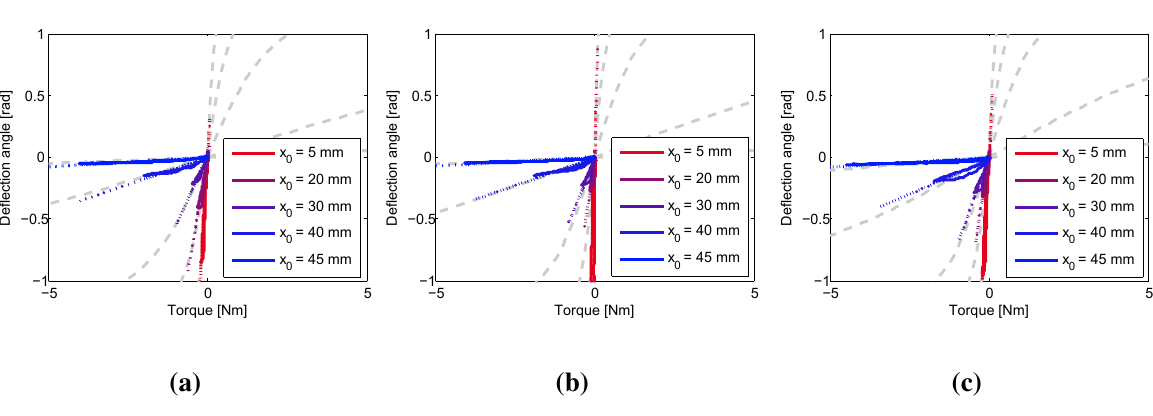
Figure 14. Deflection/torque measurement results using a single-leaf spring (for clarity, only half of the measurements are shown). The dashed line represents the simulated deflection/torque data, and the dotted line is the linear least squares approximation to the deflection/torque data. ( a ) Uniform; ( b ) negative parabola; ( c ) positive parabola.